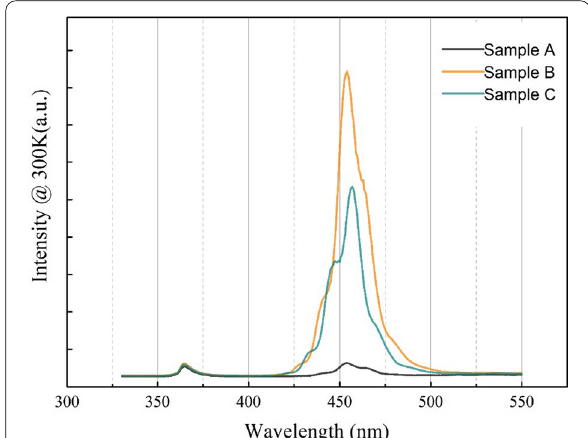
Fig. 1 The PL spectra of three samples at 300 K. The luminescence intensity of sample B treated with 100sccm hydrogen is the strongest among the three